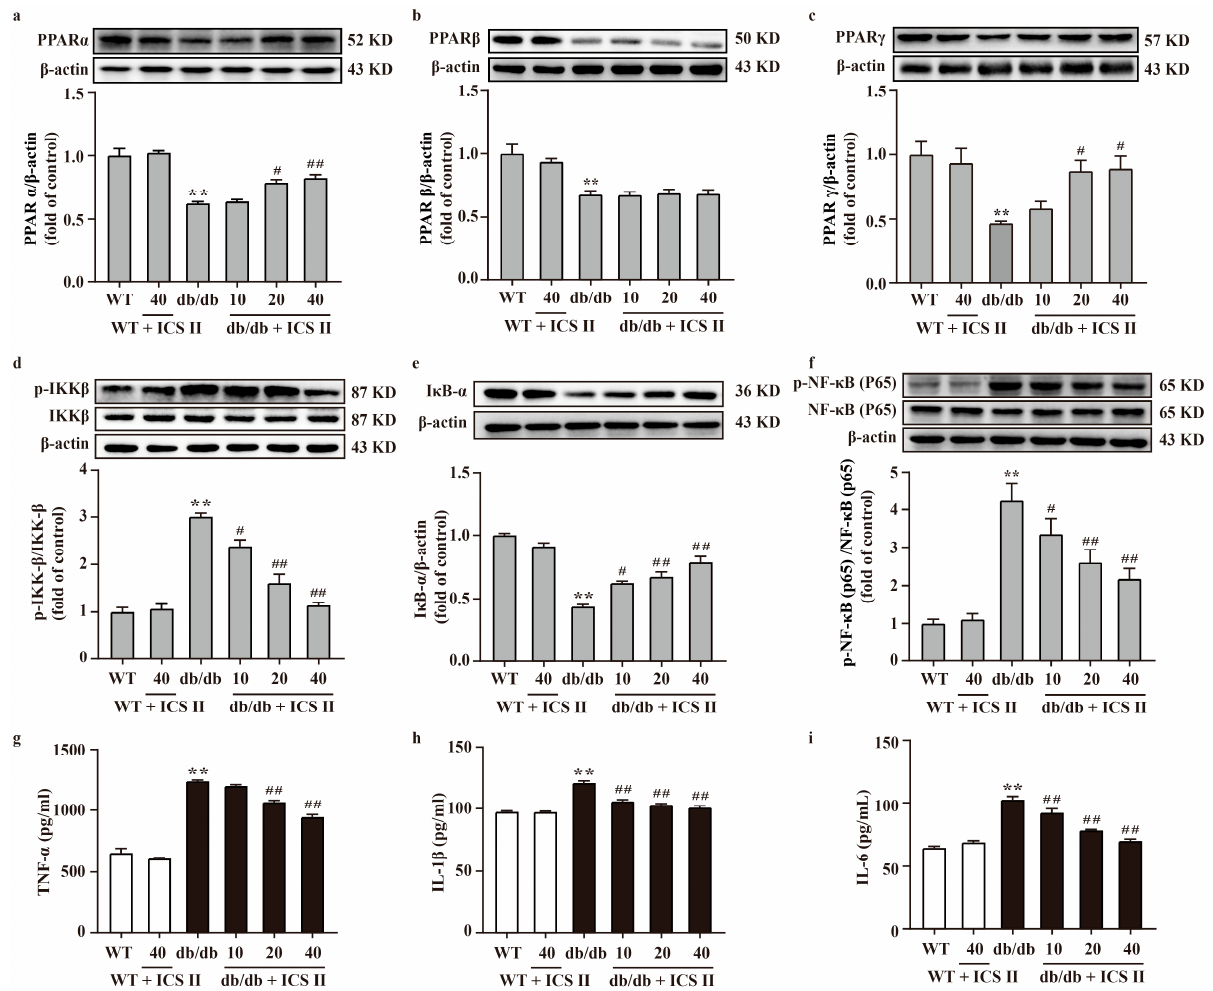
Figure 5. Effect of ICS II on the protein expressions of PPAR α , PPAR β , PPAR γ , and NF- κ B signaling pathway in the liver of db/db mice. Representative western blot and quantitation of PPAR α ( a ), PPAR β ( b ), and PPAR γ ( c ) protein expressions in the liver ( n = 5). ( d ) Representative western blot of phosphorylation of IKK β protein level and quantitation of phosphorylation of IKK β protein level in the liver. ( e ) Representative western blot of I κ B- α protein expression and quantitation of I κ B- α protein expression in the liver. ( f ) Representative western blot of phosphorylation of NF- κ B (p65) protein level and quantitation of phosphorylation of NF- κ B (p65) protein level in the liver ( n = 5). Serum inflammatory factors were measured, including TNF- α ( g ), IL-1 β ( h ), and IL-6 ( i ) ( n = 8). Data were expressed as mean ± SEM. ** p < 0.01 versus WT group; # p < 0.05 and ## p < 0.01 versus db/db group.